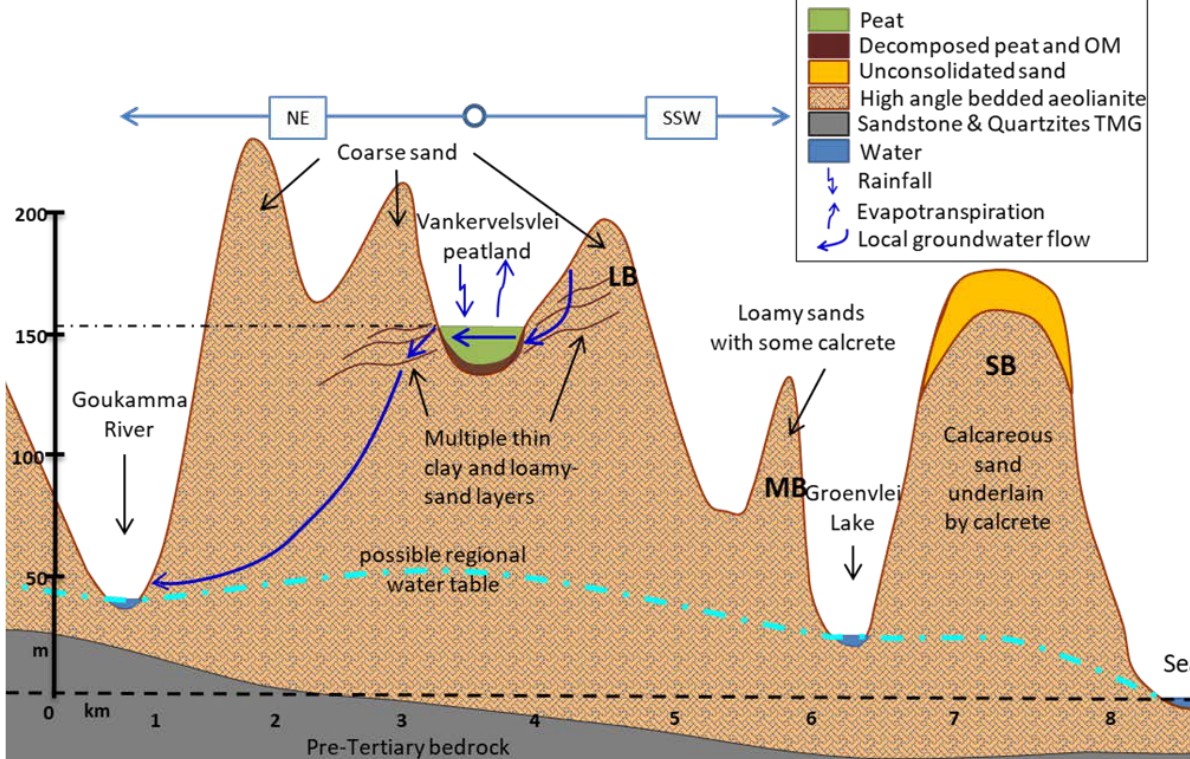
Figure 6. Conceptual model of the hydrological system (main water flows) supporting the Vankervelsvlei mire superposed on the geo(morpho)logical model of the barrier dune landscape proposed by Bateman et al . (2011) for the Kosi Bay area of the Maputaland Coastal Plain (see also Botha & Potrat 2007, Grundling et al . 2014, Kelbe et al . 2016). LB: landward barrier; MB: middle barrier; SB: seaward barrier (Bateman et al. 2011, Illenberger